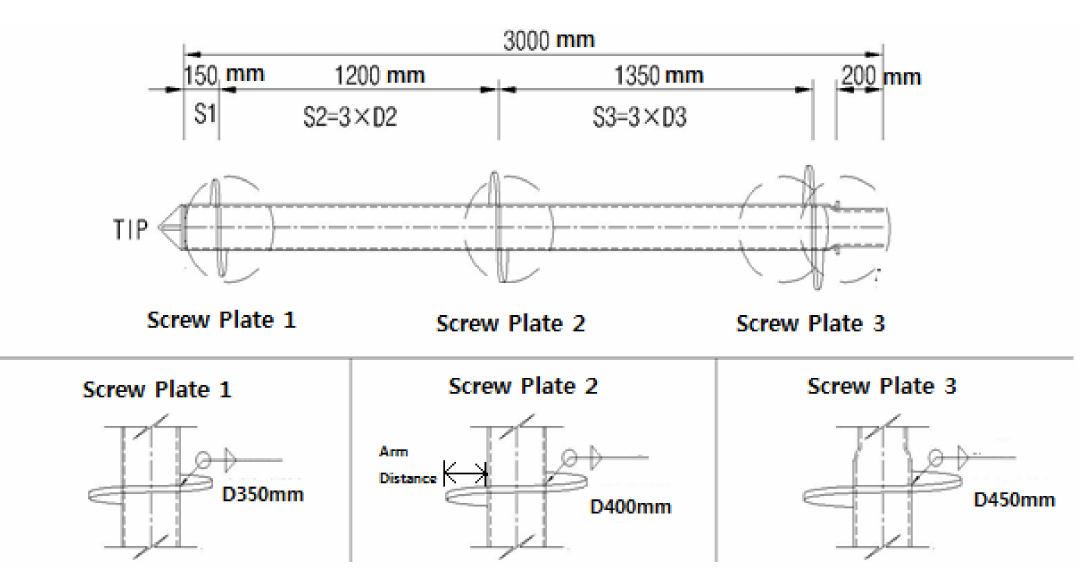
Figure 3. End of the helical pile shown in